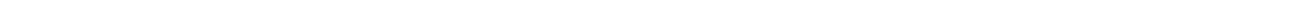
Figure 1 | Nuclear indentation does not correlate with the directionality of the migration. ( a , b ) Fs(2)Ket-GFP (green) outlining nuclear envelope and PH PLC- q 1 -RFP (red) revealing plasma membrane were used to monitor nucleus migration between stages 6 ( a ) and 7 ( b ). Oocyte orientation and nuclear dimensions are indicated (A: Anterior, P: Posterior, D: Dorsal and V: Ventral). The pink A-P dash line ( b ) highlights the symmetry axis of the oocyte. ( c ) 3D rendering of a discrete nuclear migration event from the posterior to the antero-dorsal cortex. The position of the nucleus centre enables the identification of three consecutive phases: premigration (blue), migration-proper (green) and cortical docking (pink). ( d – f ) Correlation between indentation and directionality. Angles between the vector F of the forces (red in d ) and the vector D of nuclear displacement (yellow in d ) were calculated at each time point of time-lapse movies. Example of a time-lapse recordings ( d ) used for this calculation. ( e ) Histogram of the distribution of angles for the 223 time points analysed from 50 independent nuclear displacements. ( f ) Correlation analysis between a potential phase lag and the correlation between the nuclear indentation and the nuclear displacement. The theoretical function of a perfect correlation is represented in red with an R 2 of (cid:2) 1. Different lag-times were considered: 0, 15, 30, 45, 60, 75min (see Methods). ( g – i ) MTdensities were monitored over different time points and oocytes. Trapezoid boxes of a fixed volume were defined ( g ) by subdividing the oocyte cytoplasm into 12 sectors (S1–S12) surrounding the nucleus that were further subdivided into trapezoids. A colour-coded heat map spanning 256 levels of fluorescence highlights fluorescence intensities ( g ). Dashed and solid lines highlight oocyte and nucleus limits. ( h , i ) Selected frames at indicated time points from a representative example of a time-lapse movie showing MTdensities ( h ) and the graphical representation ( i ) of the same images. Scale bar, 10 m m ( d , h , i ). ( j – l ) Mean MTdensities for 31 nuclear migrations analysed at three time points: prior to migration ( j ), mid-migration ( k ) and migration completion ( l